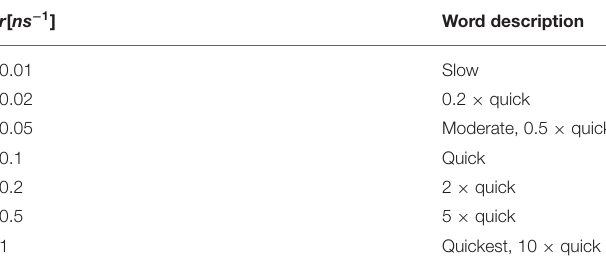
TABLE 1 | List of stretching rates ( r ) applied in this